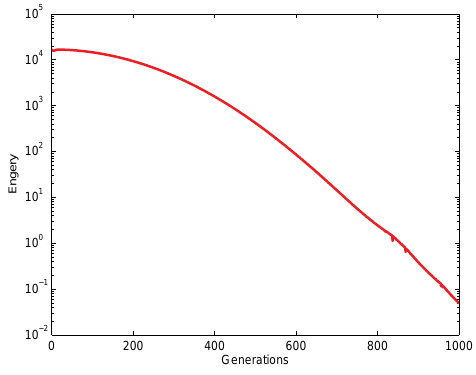
Figure 4: The sum energy of all solutions in the whole process